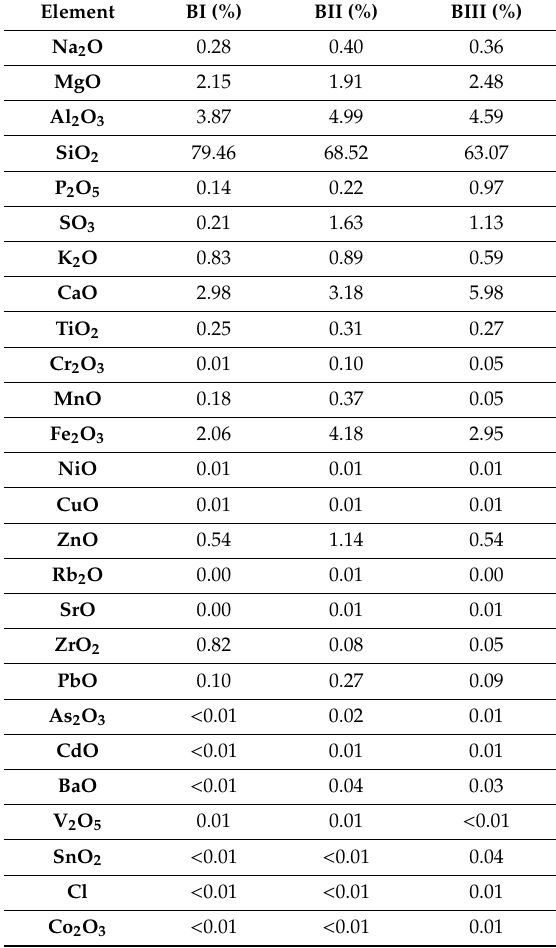
Table 2. Chemical composition of the samples BI, BII and